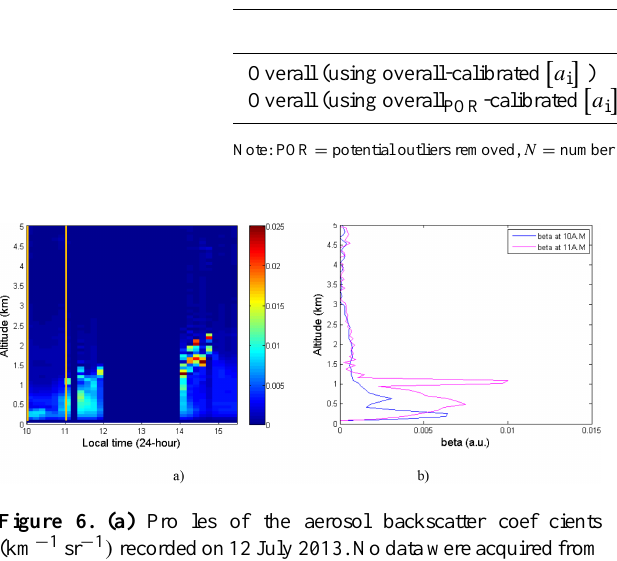
Table 4. Validation results (data for subset 2) for the AOD prediction model (Eq. 2) from 2012 and 2013 data.